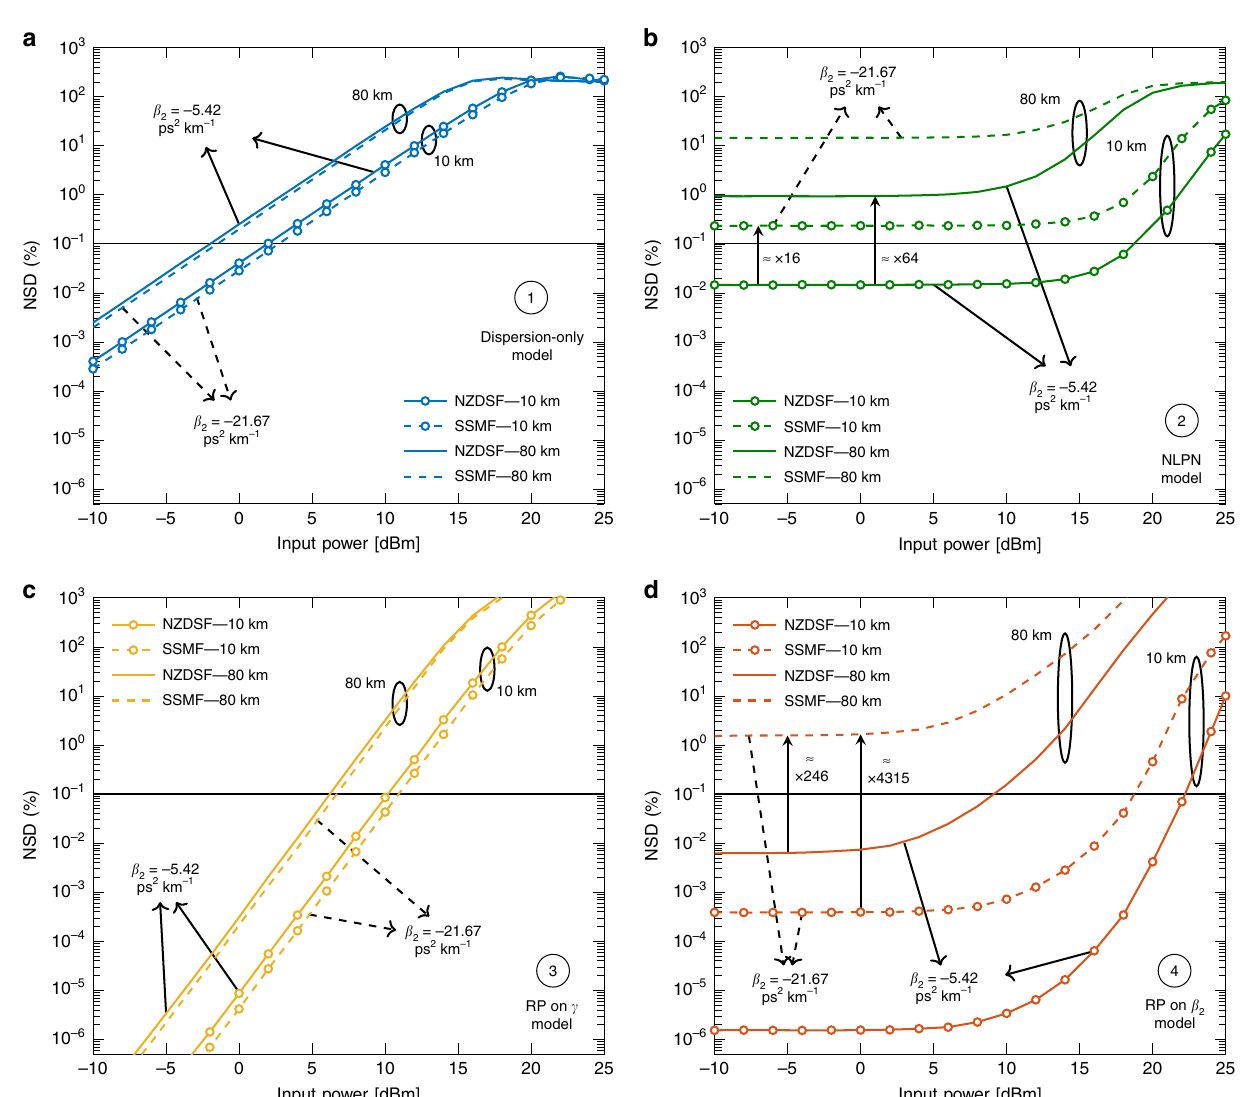
Fig. 3 NSD for the four described models as a function of the input power. Two fi bre lengths (10 and 80 km) and two types of fi bre (NZDSF and SSMF). a Dispersion-only model given by (8). b NLPN model given by (12). c RP on γ model given by (15). d RP on β 2 model given by (19). Each model has a different accuracy, measured in NSD, for a speci fi c set of input powers, β 2 coef fi cient, and distance. The black horizontal line represents a constant 0.1% NSD, which is used for comparison between